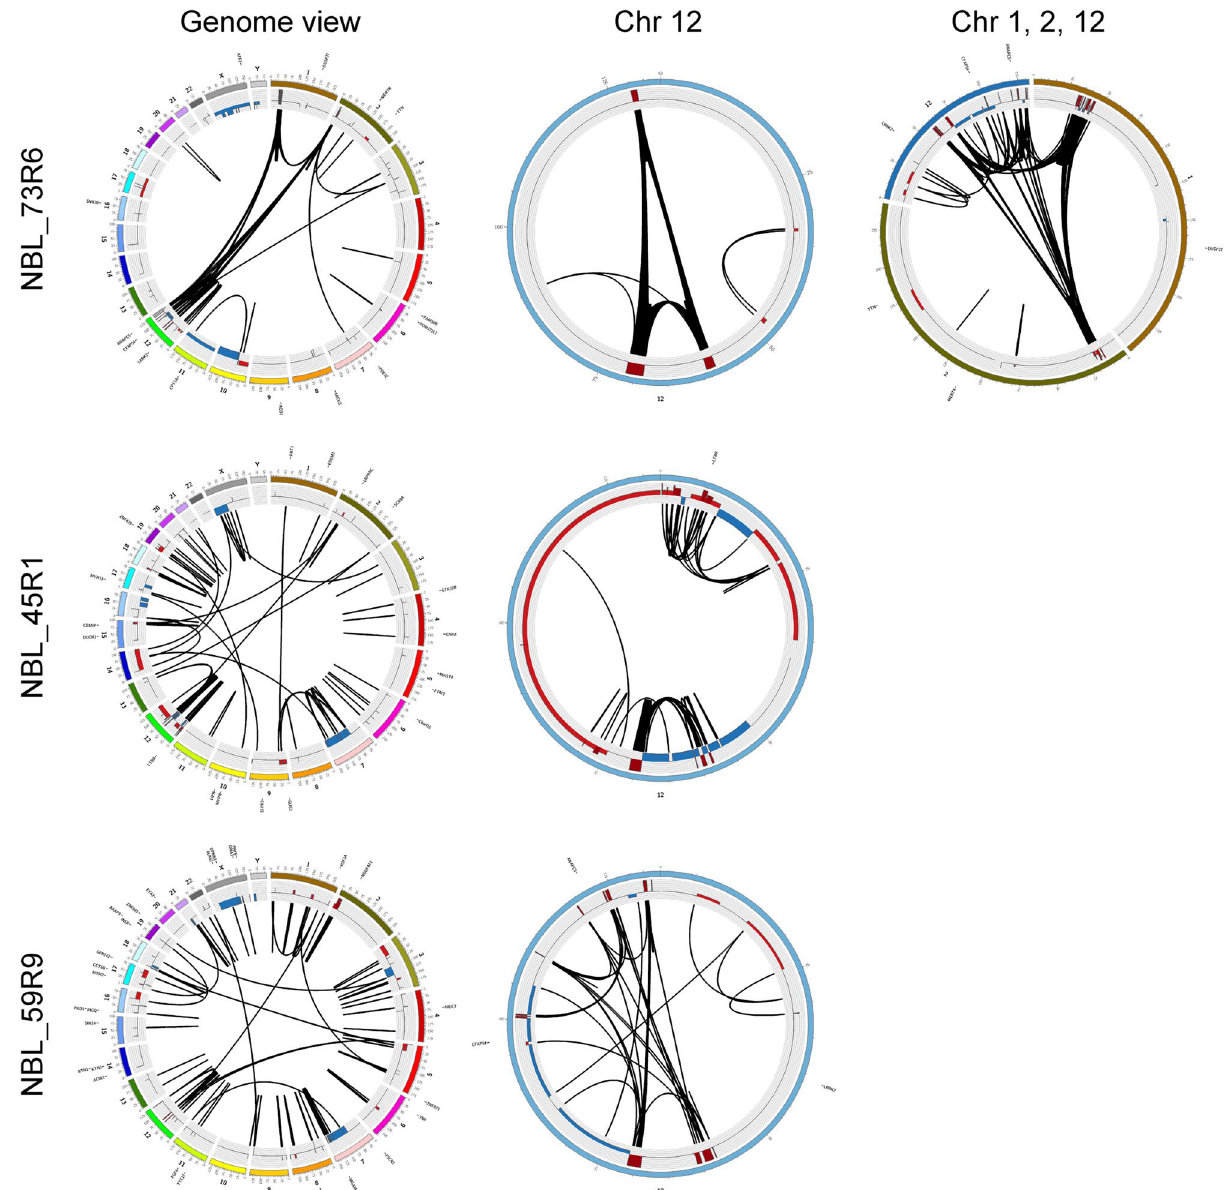
Figure 3. Mutational spectra and structural variants in 12q-amplified tumors. Circos plots showing structural variants, CNAs, and somatic SNVs. Copy number plots calculated based on the coverage ratio between tumor and corresponding normal tissue are shown on the inner circle, with gain of genomic material indicated in red and loss of genomic material indicated in blue. The lines within the inner circle indicate structural variants within and between chromosomes, while genes affected by somatic SNVs are shown outside the outer